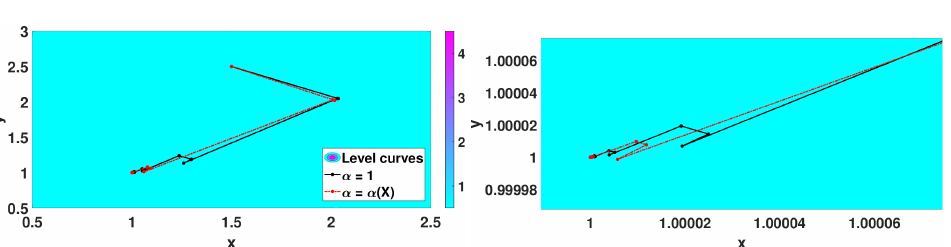
Figure 10. Iterates for f 2 ( Ψ 1 ( X )) .